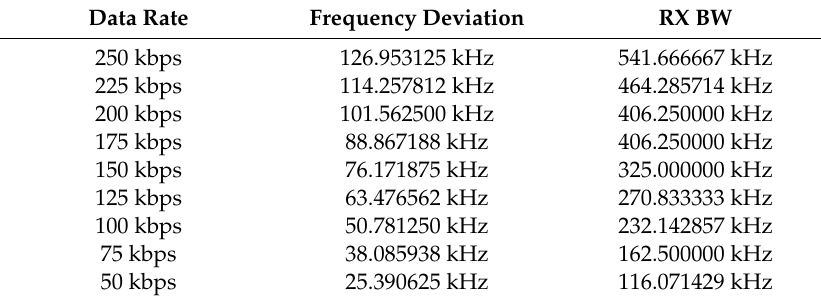
Figure 4. Diagram of TDMA architecture. Table 1. Parameters of di ff erent data